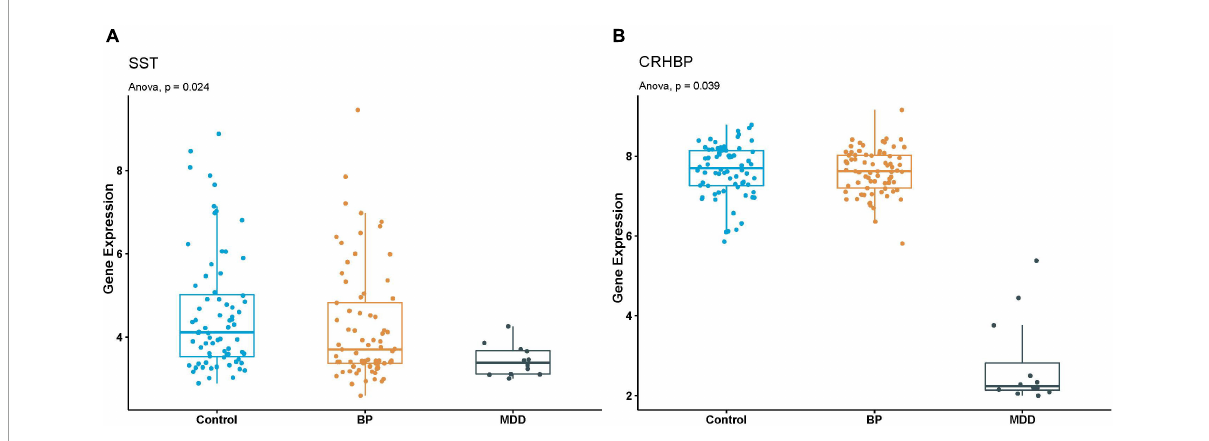
FIGURE5 (A,B) Boxplot of SST and CRHBP expression in GSE87610. P -value of Anova analysis were also presented for each gene in Control, BP and MDD